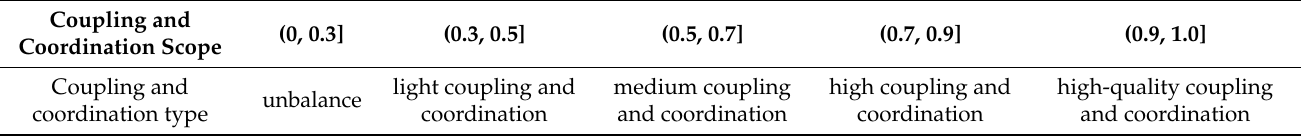
Table 2. Types and division criteria of coupling coordination